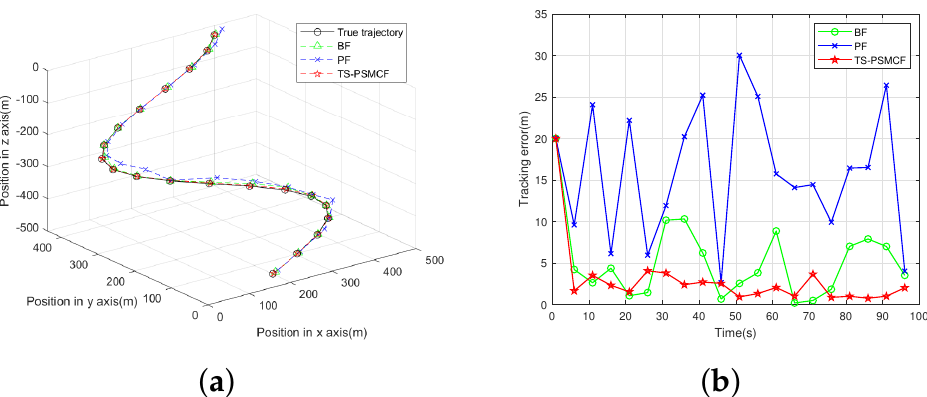
Figure 13. Simulation of TS-PSMCF with PSM (tracking error). (a) The motion trajectory of the target and the tracking trajectory of the three algorithms. (b) Tracking error.